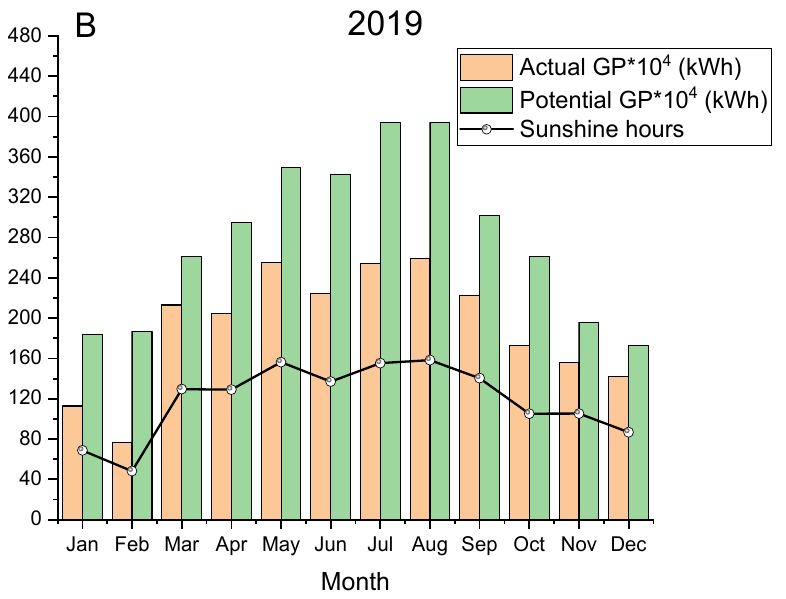
Figure 9. Potential generation power (GP) and actual GP of the solar PV power plant alongside monthly sunshine hours for: ( A ) 2018 and ( B ) 2019.